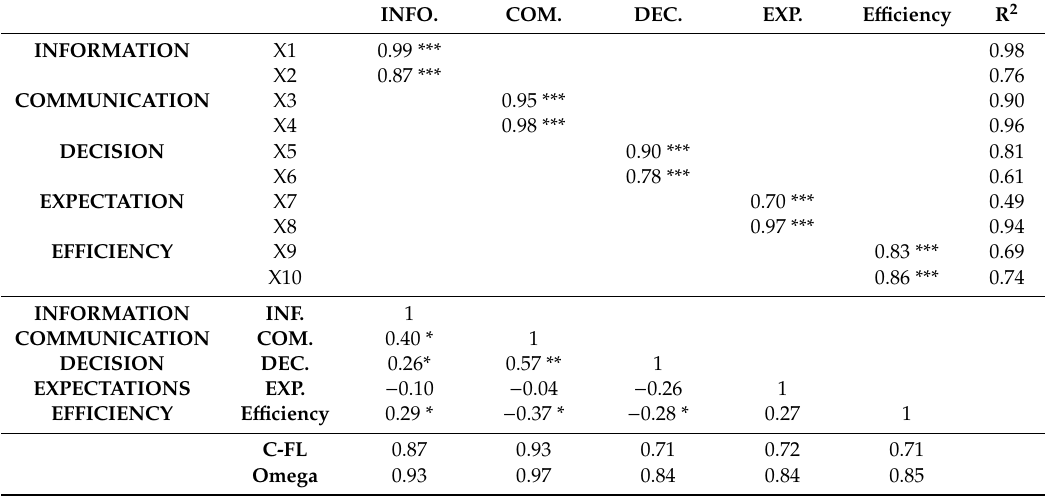
Table 8. Confirmatory factor analysis model.